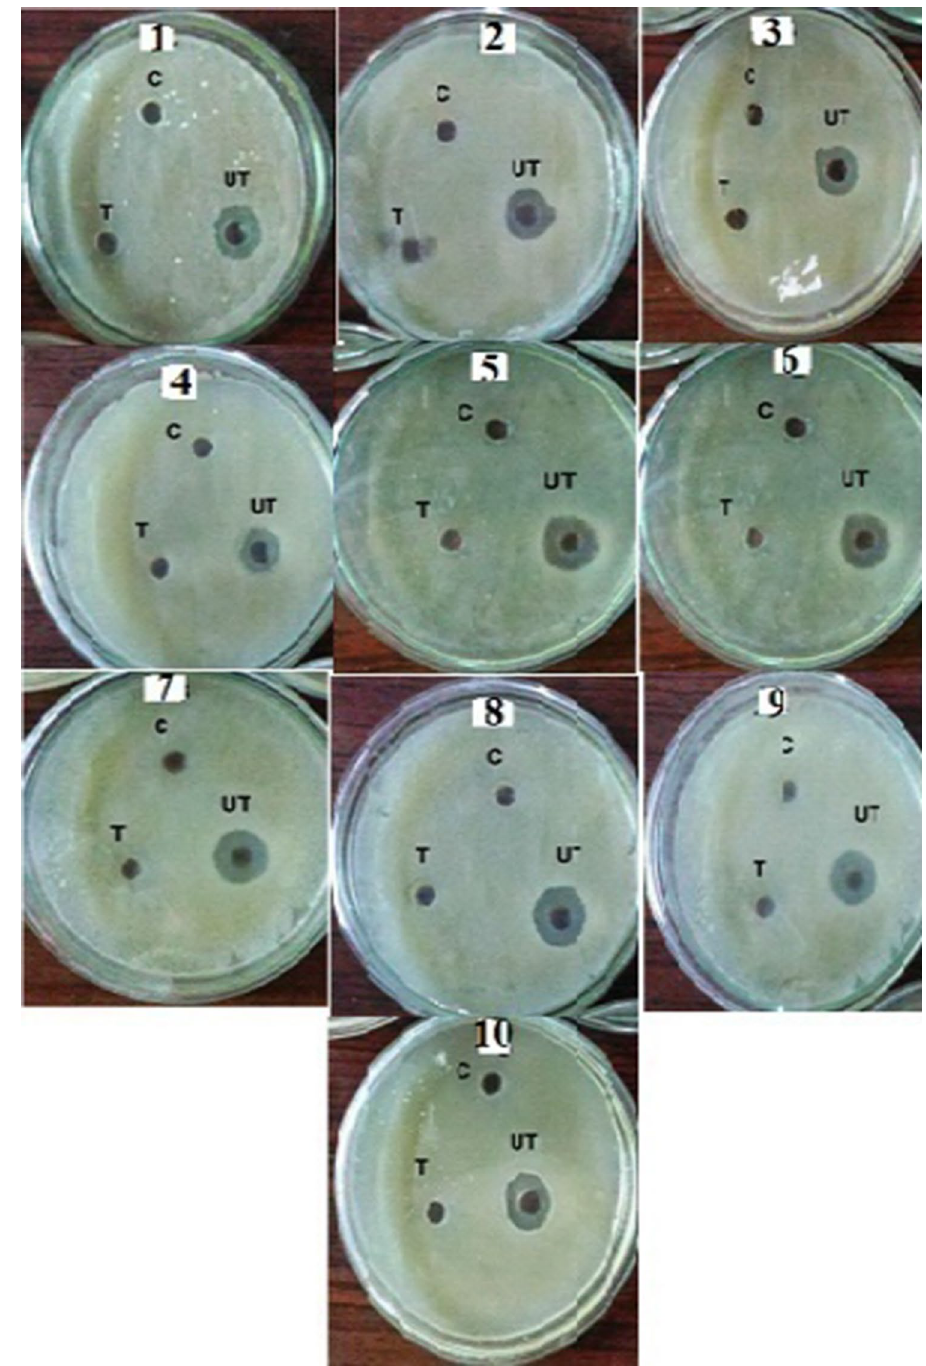
Fig. 2 Toxicity (bacterial) of the untreated and treated dye samples against 1.